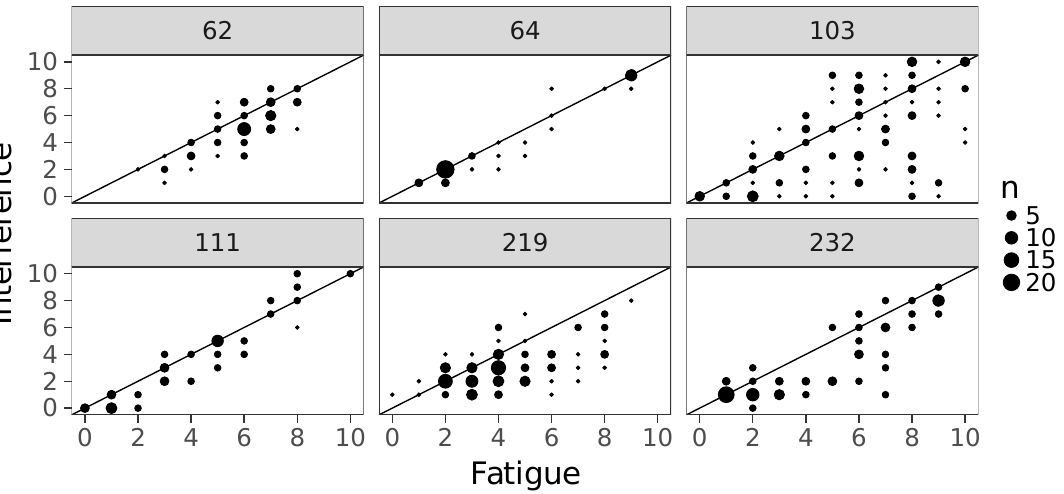
Figure 8. Scatter plots of Fatigue vs. Interference of all digital questionnaires per patient: the dot size represents the count of a VAS value pair. The diagonal denotes where Fatigue equals Interference.